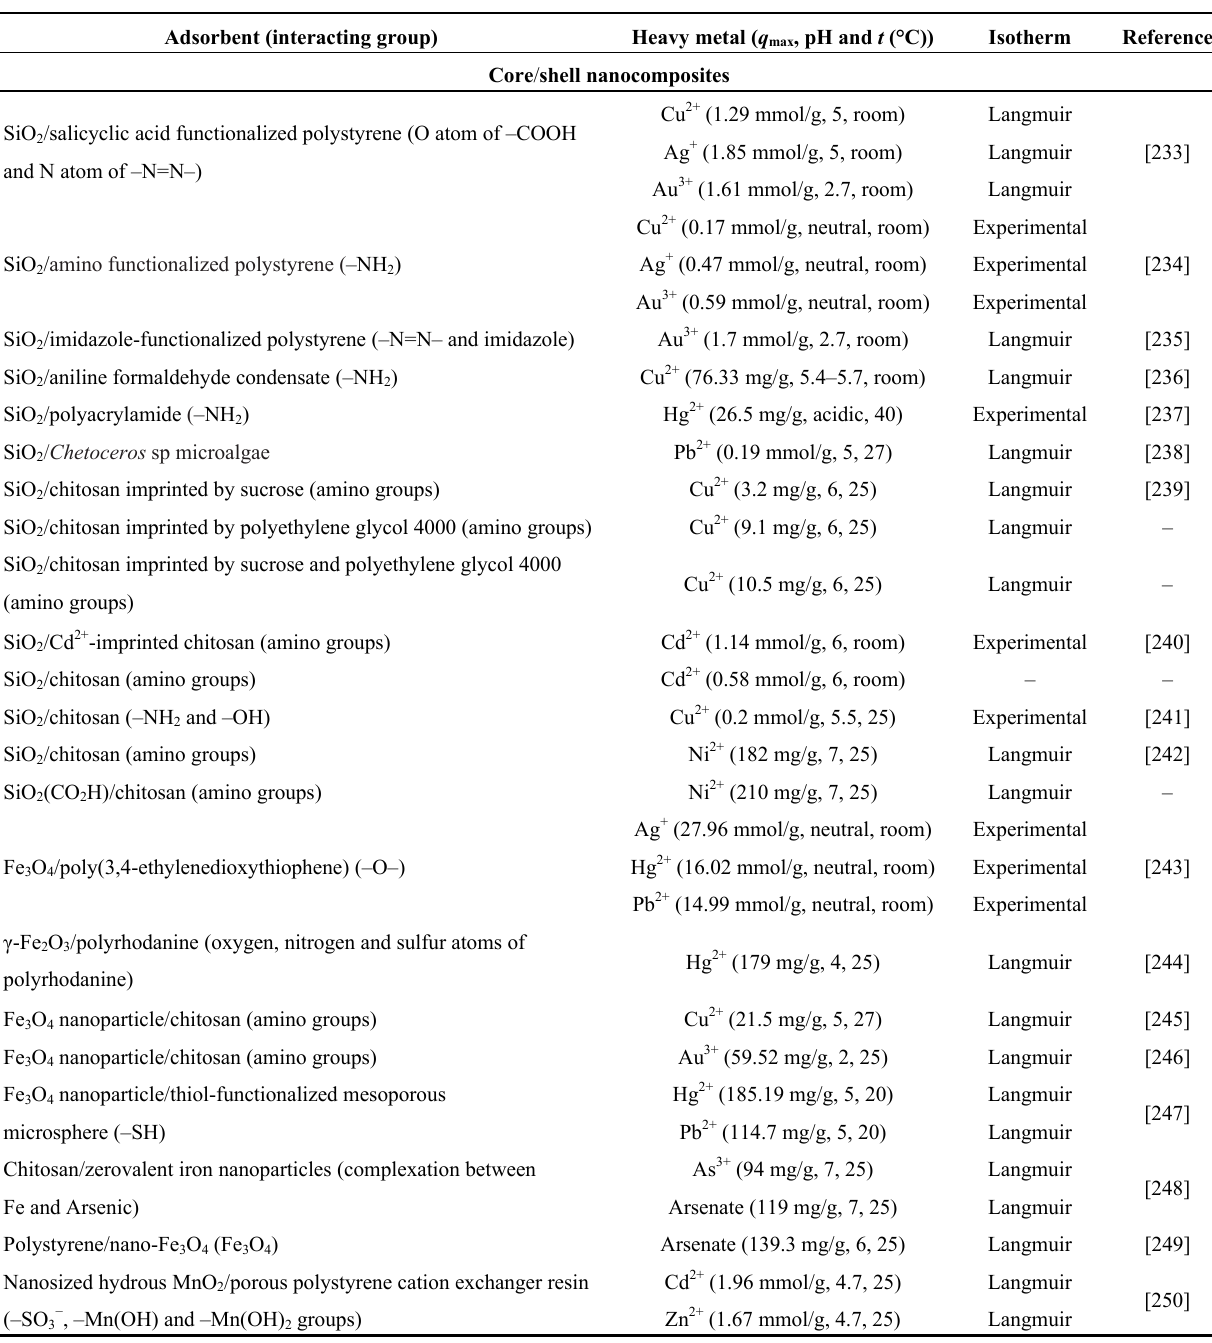
Table 4. Adsorbed heavy metals, maximum adsorption capacity, pH and temperature for adsorption of heavy metals by organic-inorganic core/shell and hierarchically structured